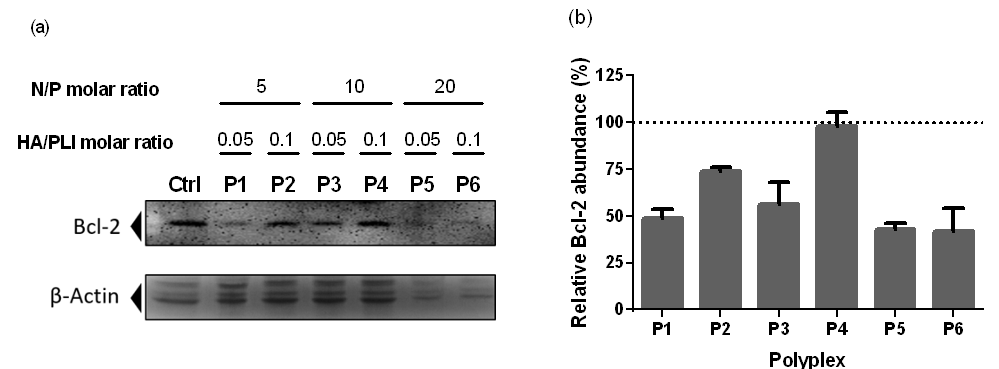
Figure 6. Protein expression levels of Bcl-2 in the MDA-MB-231 cells by Western blot analysis. Cells were treated for 24 h with the nanopolyplexes. ( a ) The Bcl-2 protein level was determined by Western blotting using anti-Bcl-2 antibody; N / P and HA / PLI molar ratios for each polyplex are included in the figure. ( b ) Graph showing the relative Bcl-2 abundance calculated as a percentage of the control. Each value represents the mean ± S.E.M. from duplicate determinations.